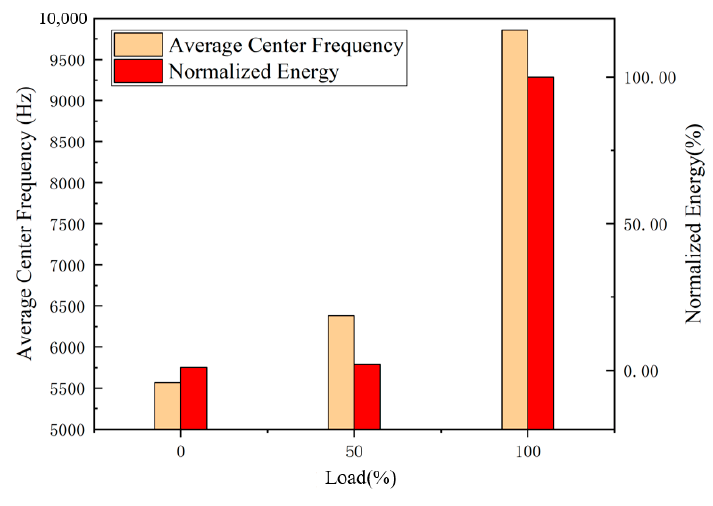
Figure 17. The average center oscillation frequency and the normalized average oscillation energy under different loads.